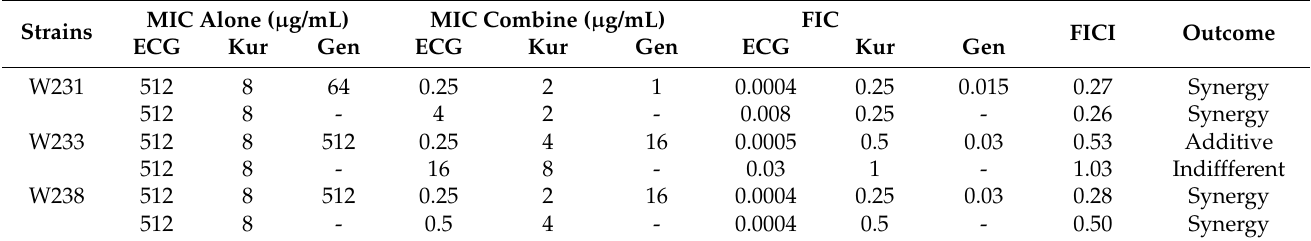
Table 3. Minimum inhibitory concentrations (MIC) ( µ g/mL) and fractional inhibitory concentra- tion indices (FICI) of kuraridin and epicatechin gallate (ECG) with or without gentamicin against gentamicin (Gen) resistant MRSA strains.